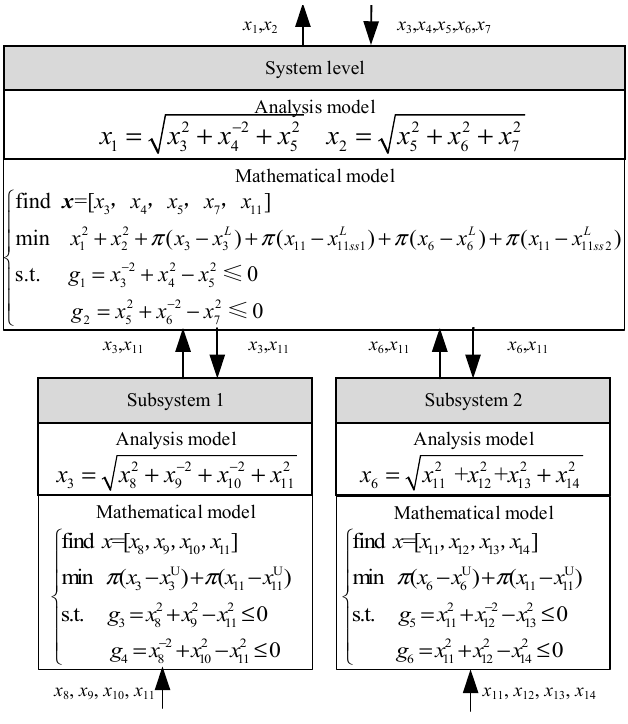
Figure 4. ATC decomposition framework of the example.